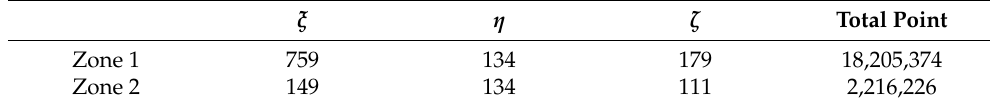
Table 1. Number of computational grid points.